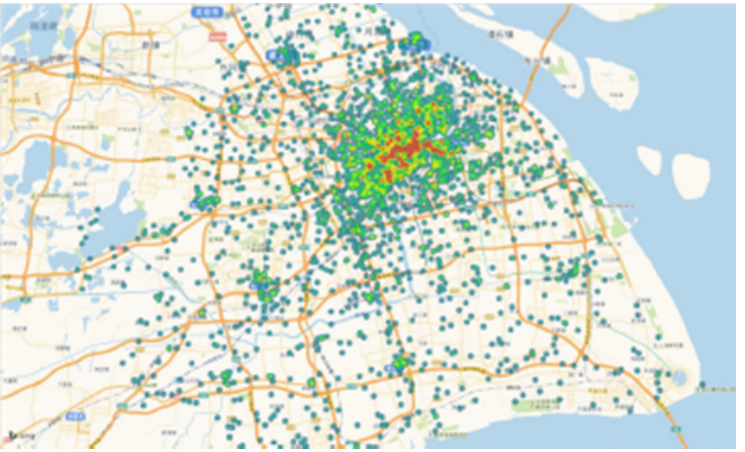
Figure 3. Graphical depiction of base station locations in Shanghai Telecom dataset